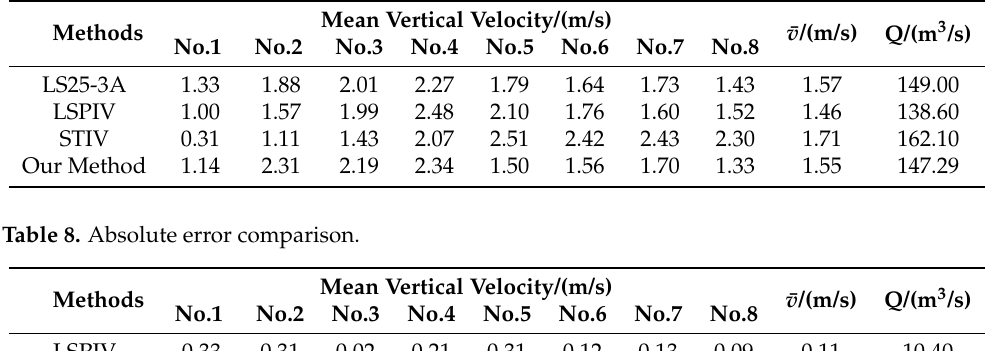
Table 7. Comparison of measurement results by different methods.